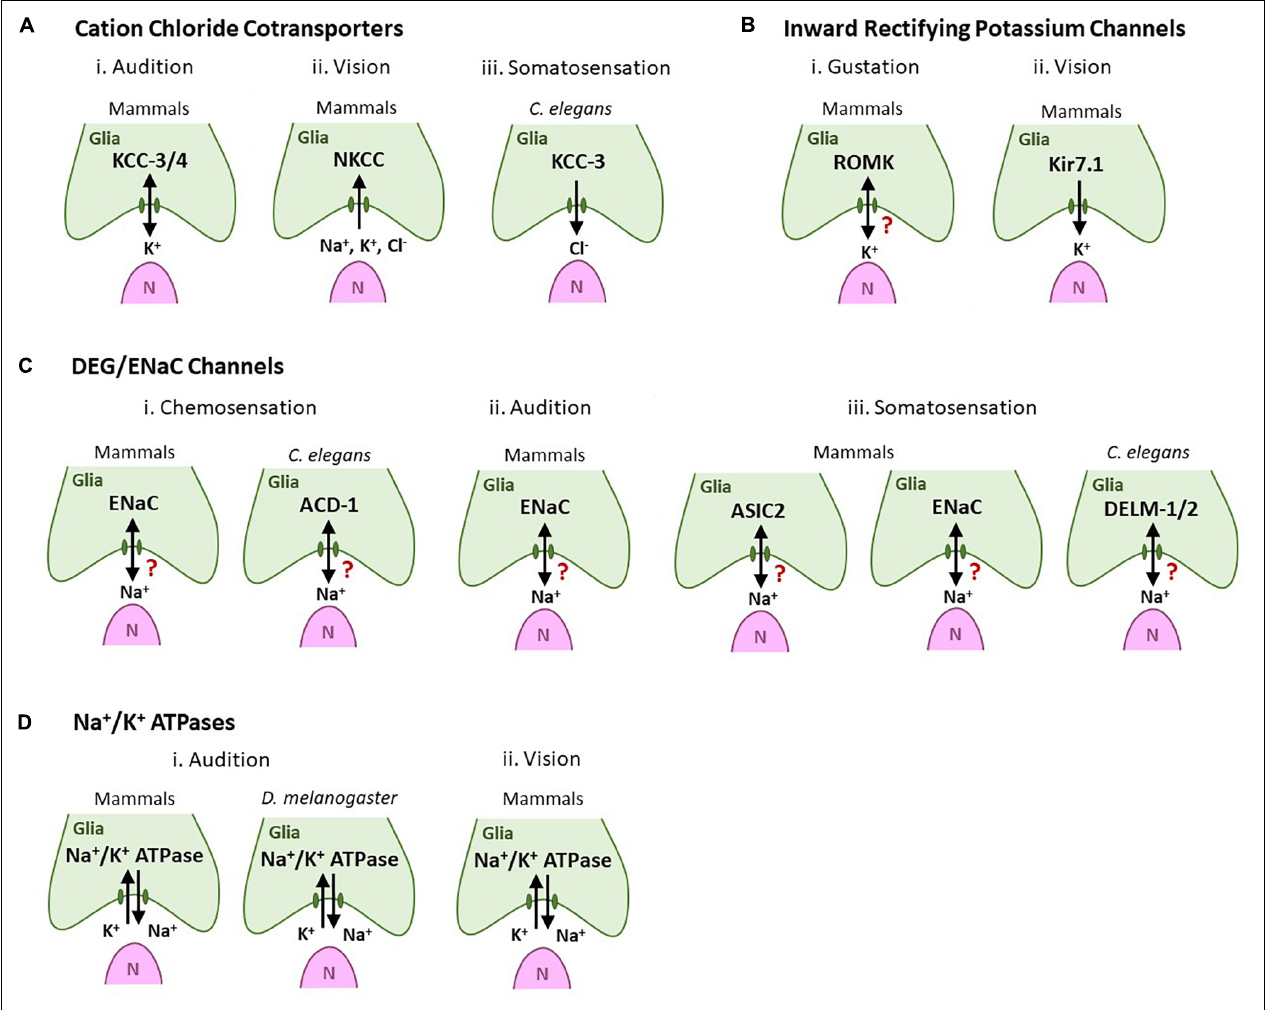
FIGURE 3 | Glial ionic regulators regulate sensory neuron shape and functions across sensory modalities and species. Green cells are glia-like support cells. Magenta cells (N) are sensory cells. Arrows denote the direction of ion movement associated with sensation. A question mark denotes cases where the direction